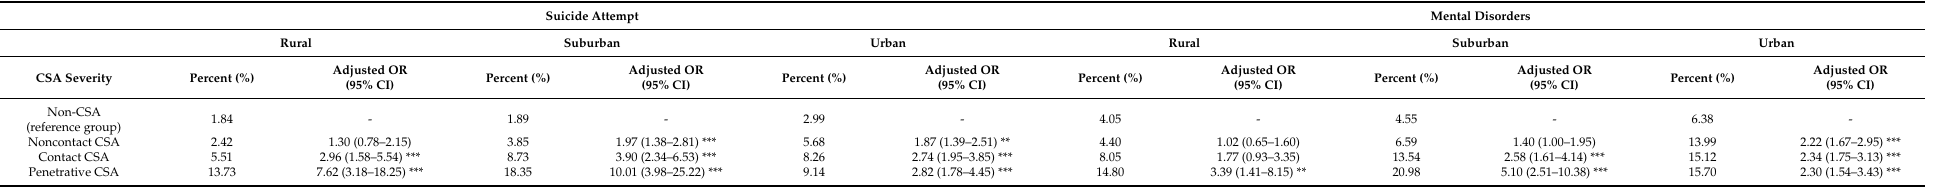
Table 4. Association between mental health and different types of CSA among respondents, stratified by the residential environment ( n = 49,728). SuicideAttempt MentalDisorders Rural Suburban Urban Rural Suburban